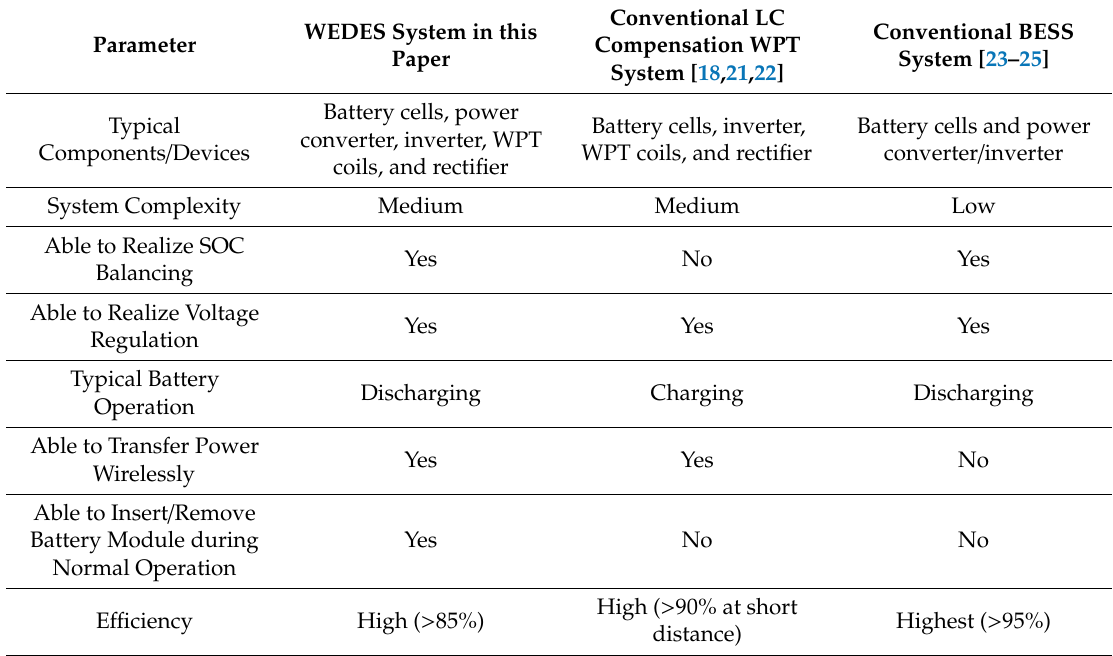
Table 2. Comparison summary between the WEDES system, conventional Inductor-Capacitor (LC) compensation wireless power transfer (WPT) system, and conventional battery energy storage system